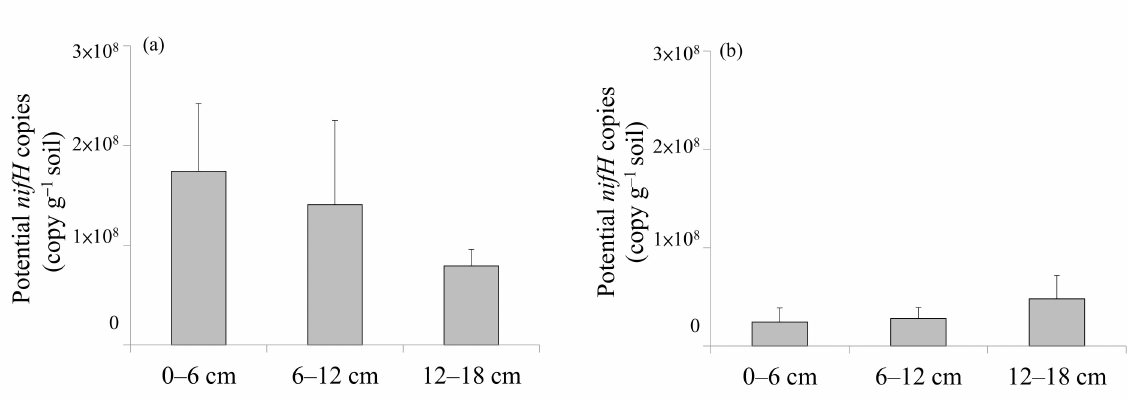
Figure 4. The number of nitrogenase gene (i.e., nifH gene) copies in fresh mangrove forest soils in Guandu ( a ) and Bali ( b ) at the three soil depths. The height of bars and the error bars indicate the mean and standard deviation,